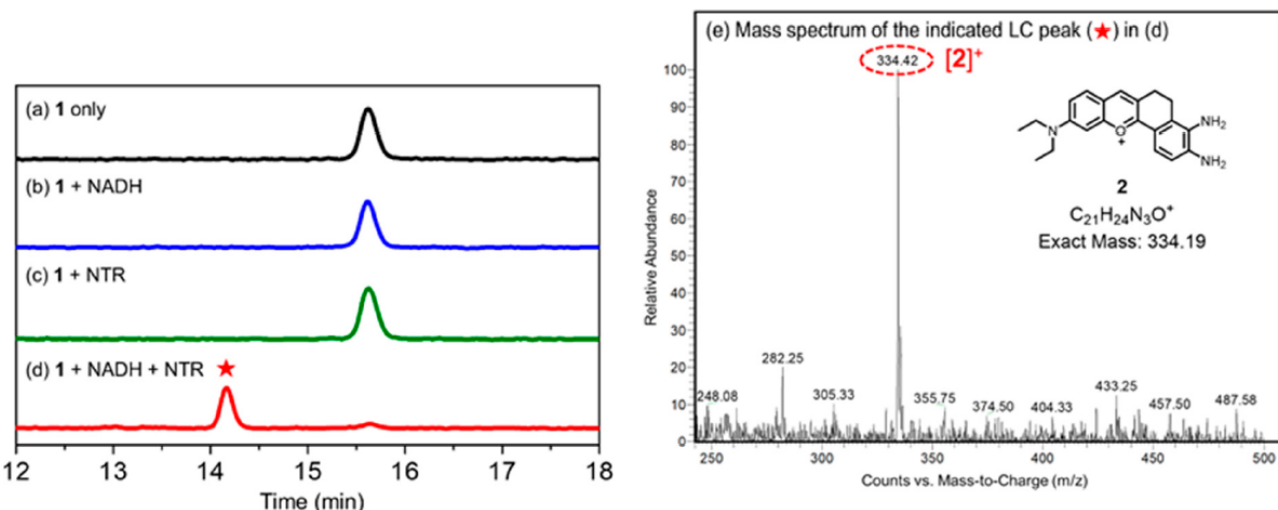
Figure 1. HPLC analyses of ( a ) probe 1 , ( b ) 1 +NADH, ( c ) 1 +NTR, and ( d ) 1 +NADH+NTR. HPLC peaks were detected by recording absorbance at 450 nm. ( e ) ESI-MS spectrum of the eluent at 14.1 min ( (cid:70)